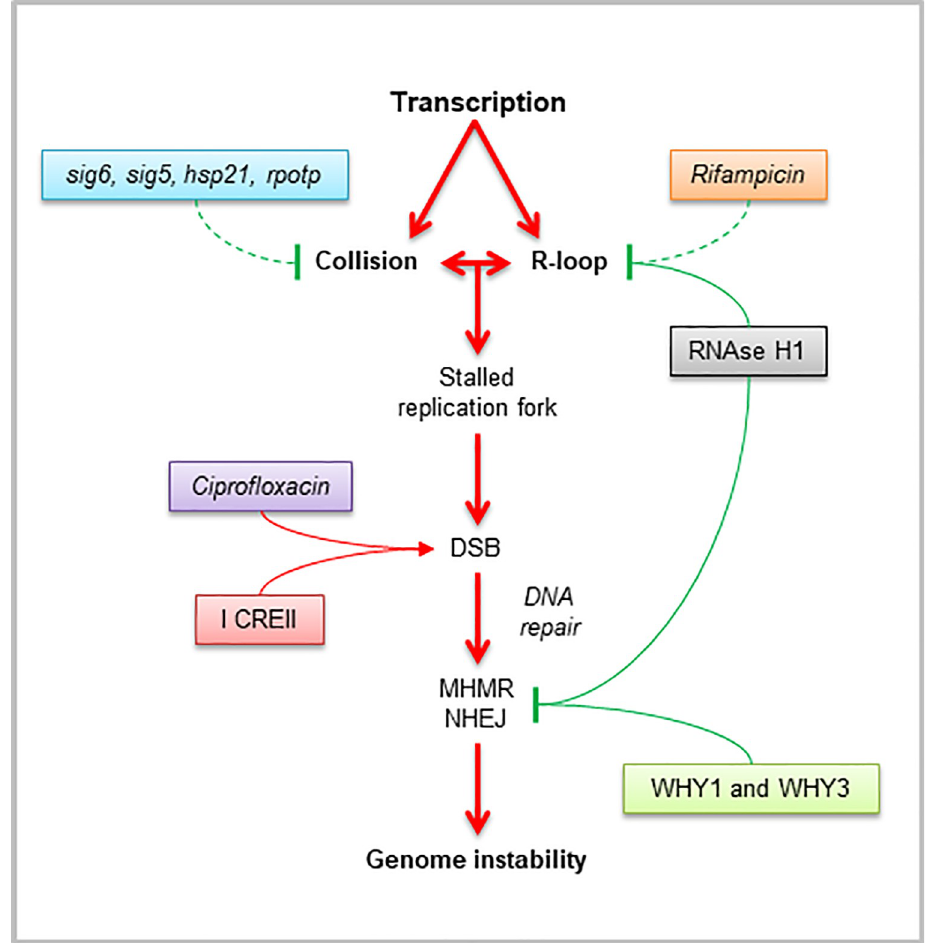
Fig 6. Proposed model for transcription-associated genome instability in plastids. Transcription-driven genome instability could be explained by a possible stalling of the replicating DNA polymerase when colliding with a blocked RNA polymerase or a stable DNA:RNA hybrid or by a major susceptibility of the displaced ssDNA in R-loops to DNA damage. Then, a collapsed replication fork or a DNA lesion could subsequently generate a double-stranded break (DSB), which in the presence of Whirly proteins (WHY1 and WHY3) could be repaired by error-free mechanisms before replication restart. Conversely, in the absence of Whirly proteins or in the presence of high DSB levels (induced throughout the entire plastid genome by ciprofloxacin treatment or at a specific locus by expression of the exogenous endonuclease I-CREII), a DSB could be repaired mainly by micro-homology-mediated repair (MHMR) and secondly by non-homologous end-joining (NHEJ), leading to genomic rearrangements. Plastid genome instability can be ameliorated by transcription impairment, possibly by reducing collisions between the replication and transcription machineries ( sig6 , sig5 , hsp21 , and rpotp mutants), as well as reducing the formation of R-loops ( why1why3sig6 mutants, treatment with rifampicin, expressing an exogenous plastid-targeted RNAse H1). Full lines represent pathways corroborated in this study and dashed lines show possible pathways according to the literature. Red arrows represent pathways leading to genome instability, whereas blunt end green lines show pathways promoting stability.